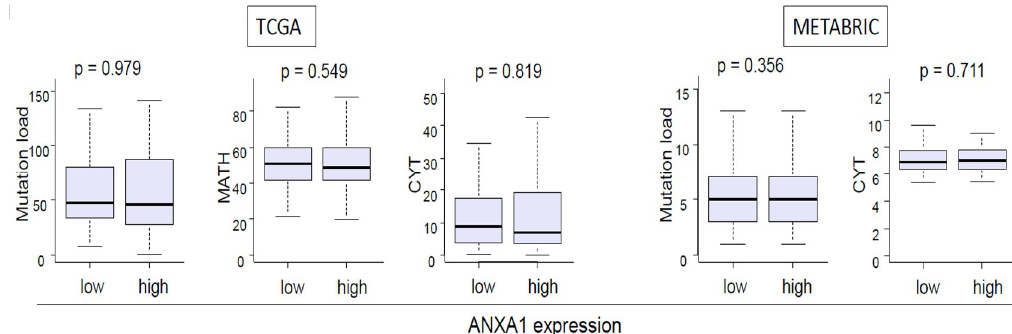
Figure 3. There is no significant difference in mutation load, mutant‐allele tumor heterogeneity (MATH) score and Cytolytic Activity Score (CYT) between ANXA1 high and low TNBC in TCGA and METABRIC cohorts.